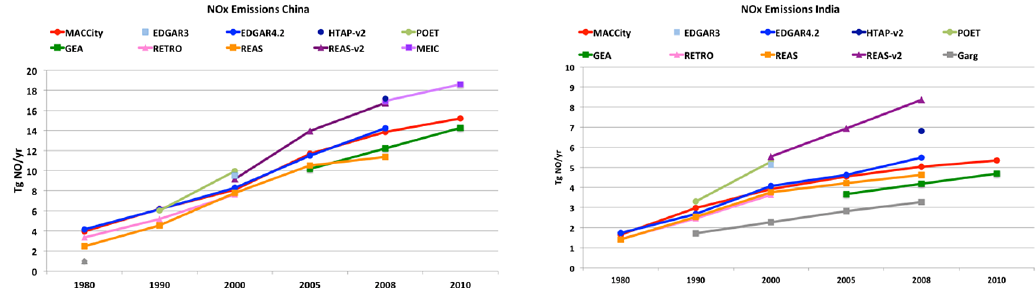
Figure 11. Evolution of NO x emissions in China and India from 1980 to 2010 provided by different global and regional inventories (units are Tg NOyr − 1